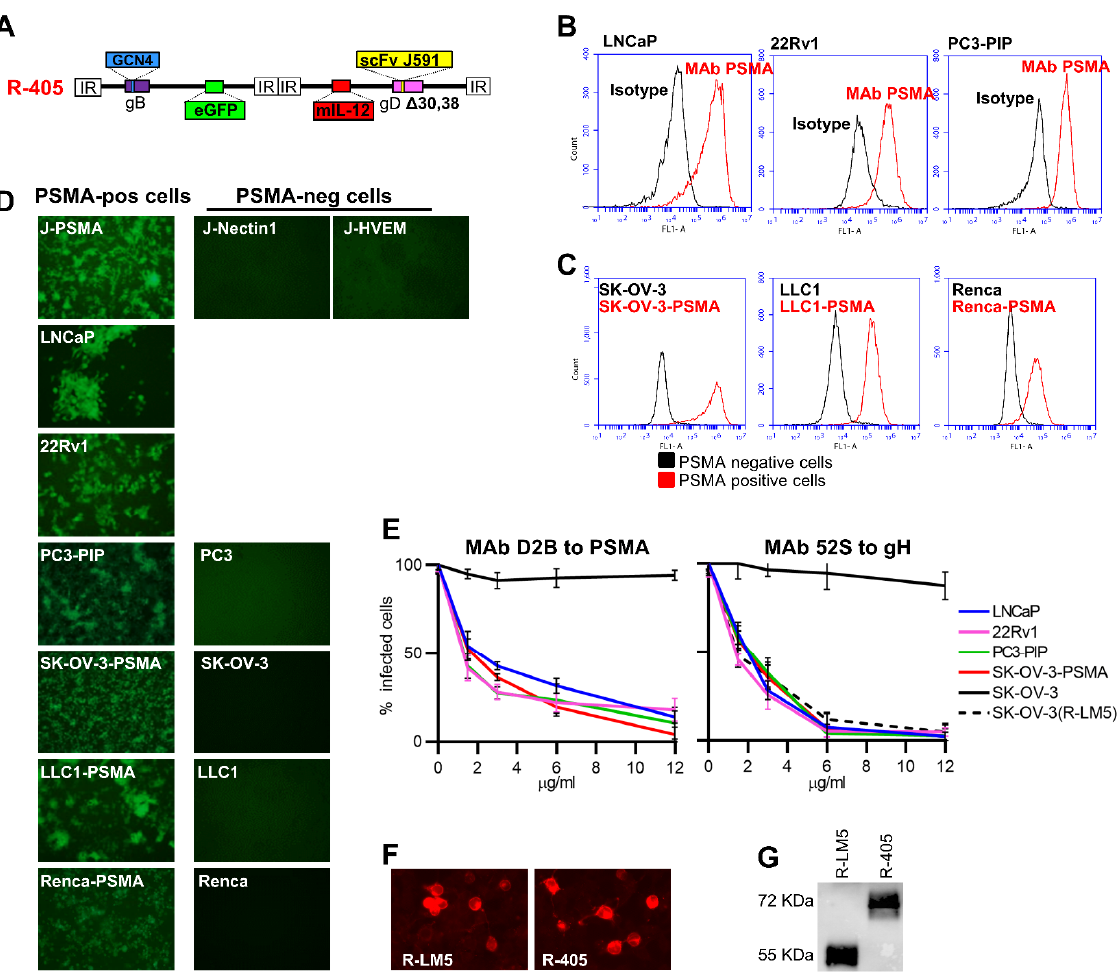
Figure 1. Tropism of R-405 for PSMA-positive cells. ( A ) Genome organization of R-405. The drawing shows the linear map of R-405 genome. Glycoprotein gB gene carries the insertion of GCN4 peptide [45]. The single peptide murine IL-12 is inserted in the US1-US2 intergenic locus. The gD gene carries the deletion of amino acid 30 and the replacement of amino acid 38 with scFv to PSMA. EGFP (enhanced green fluorescence protein) is inserted in the UL37-UL38 locus. ( B ). Flow cytometry quantification of PSMA in LNCaP, 22Rv1 and in PC3-PIP cells. Samples were reacted with MAb D2B to PSMA (red lines) or isotype control (black lines), washed twice, then reacted with the secondary antibody Alexa Fluor™ 488 anti- mouse IgG. ( C ) Flow cytometry quantification of transgenic PSMA Δ in SK-OV-3-PSMA, LLC1-PSMA and Renca-PSMA cells (red lines, details above). The corresponding wt cells were included as control (black lines). ( D ) Infection of the indi- cated PSMA-positive cells and lack of infection of PSMA-negative cells by R-405. Infection was detected by EGFP fluores- cence. Magnification 100X. ( E ) Inhibition of R-405 infection by MAb D2B to PSMA (left panel) and by neutralizing MAb 52S to HSV gH (right panel). Dotted line in the right panel: SK-OV-3 cells infected with wt R-LM5. Each column is the average of triplicate samples ± standard deviation (SD). ( F ) Detection of gD protein in the SK-OV-3-PSMA cells infected with R-LM5 or R-405 viruses by indirect immunofluorescence. SK-OV-3-PSMA were infected with the indicated virus (0.01 PFU/cell); 24 h later, cells were fixed with methanol (this treatment also quenched virus-encoded EGFP), reacted with anti-gD MAb BD80, and with the secondary antibody anti-rabbit DyLight 549. Magnification 600×. ( G ) Efficiency of gD incorporation in R-405 virions. Purified R-LM5 (lane 1) or R-405 (lane 2) virions were subjected to SDS-PAGE, transferred to nitrocellulose membranes, and visualized by Western blotting with the conformation-independent MAb BD80, directed against C-terminus of gD ectodomain (264–274 aa). gD from R-405 contained the scFv to PSMA and exhibited a lower electrophoretic mobility than wt-gD present in the R-LM5 virus. On the left, the predicted molecular weights of the wt- gD (55 KDa) and scFv(PSMA)-gD (72 KDa) are reported. 3.2. Infectivity, Cell-To-Cell Spread, and Cytotoxicity Caused by R-405 in Different Cell Lines. The extent of R-405 replication in the above cells was quantified in a virus yield ex- periment at 24, 48, and 72 h after infection. Infection was carried out at 0.1 plaque-forming